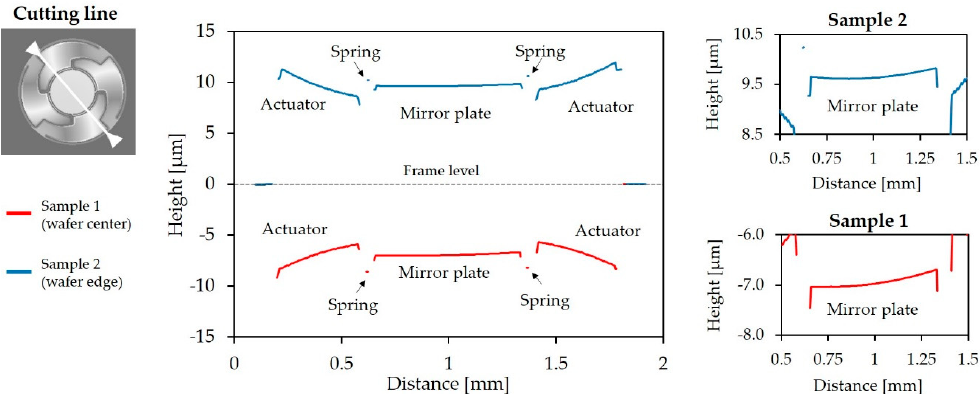
Figure 16. Cross-section of the sample micromirrors (Design 1) of the wafer center (Sample 1) and the wafer edge (Sample 2). A zoomed section of the corresponding mirror plate is shown on the right.